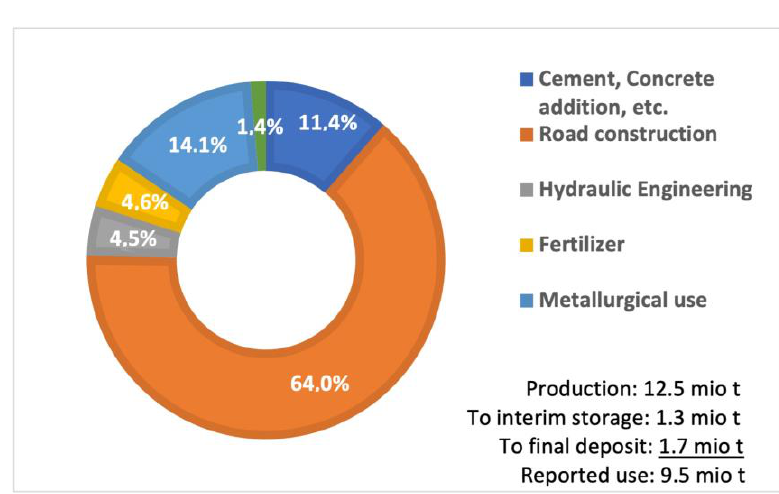
Metals 2023 , 13 , x FOR PEER REVIEW Figure 4. Use of steel slags in Europe in 2021 [4]. Figure 4. Use of steel slags in Europe in 2021 [4].